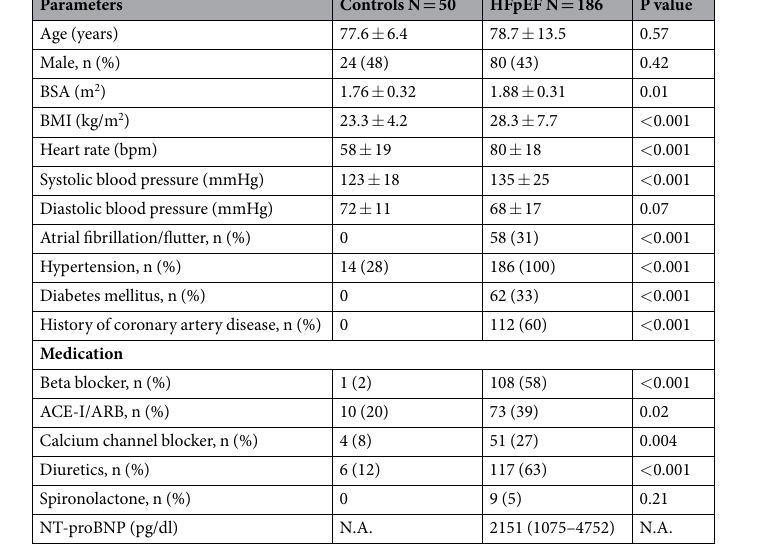
Table 1. Clinical characteristics. ACE-I; angiotensin converting enzyme inhibitor, ARB; angiotensin II receptor blocker, BMI; body mass index, BSA; body surface area.